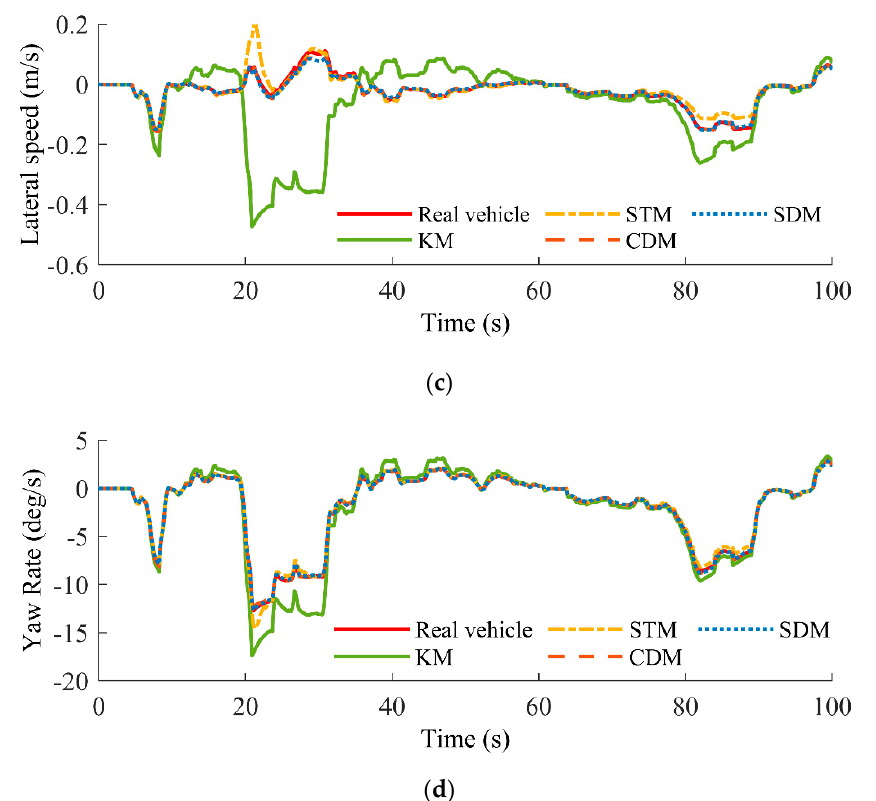
Figure 9. Comparative results: ( a ) longitudinal speed; ( b ) longitudinal coupling component of lateral force; ( c ) lateral speed; ( d ) yaw rate.